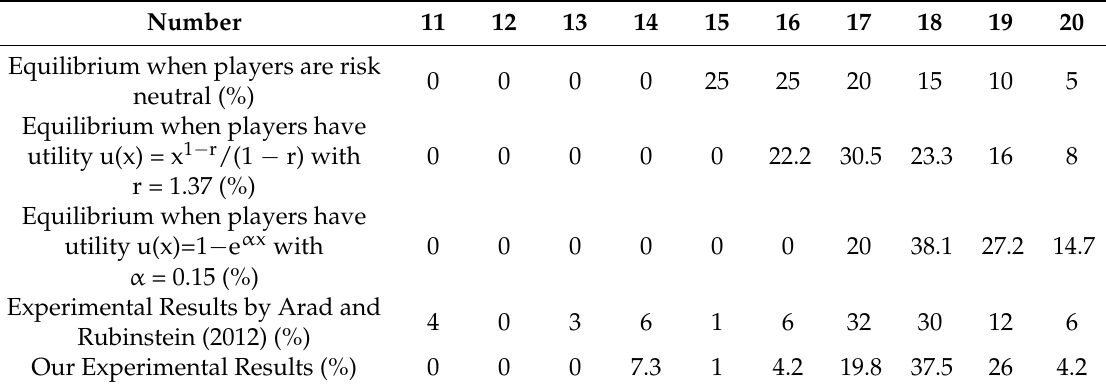
Table 1. Distribution of